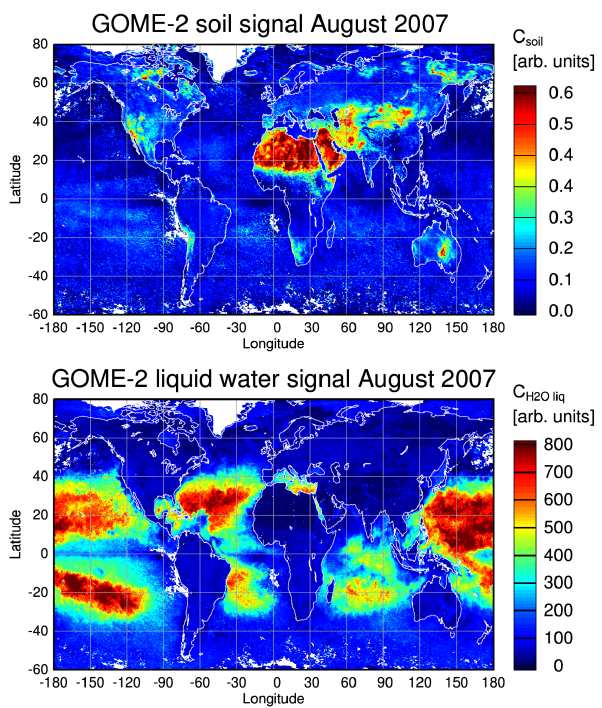
Fig. 8. Average fit coefficient of the empirical soil spectrum (top) and the liquid water spectrum (bottom) for August 2007. Only data with cloud fractions not larger than 0.2 have been included.